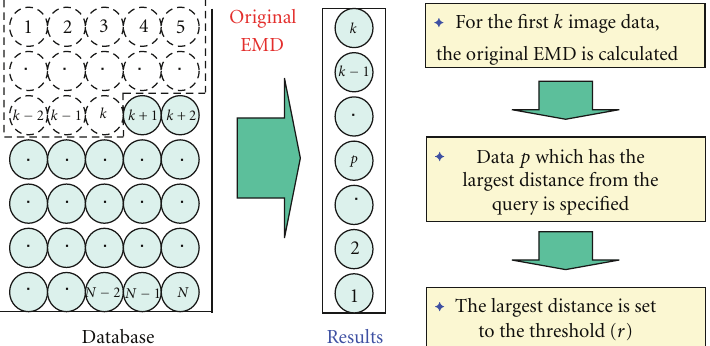
Figure 6: Algorithm for the first k image data.